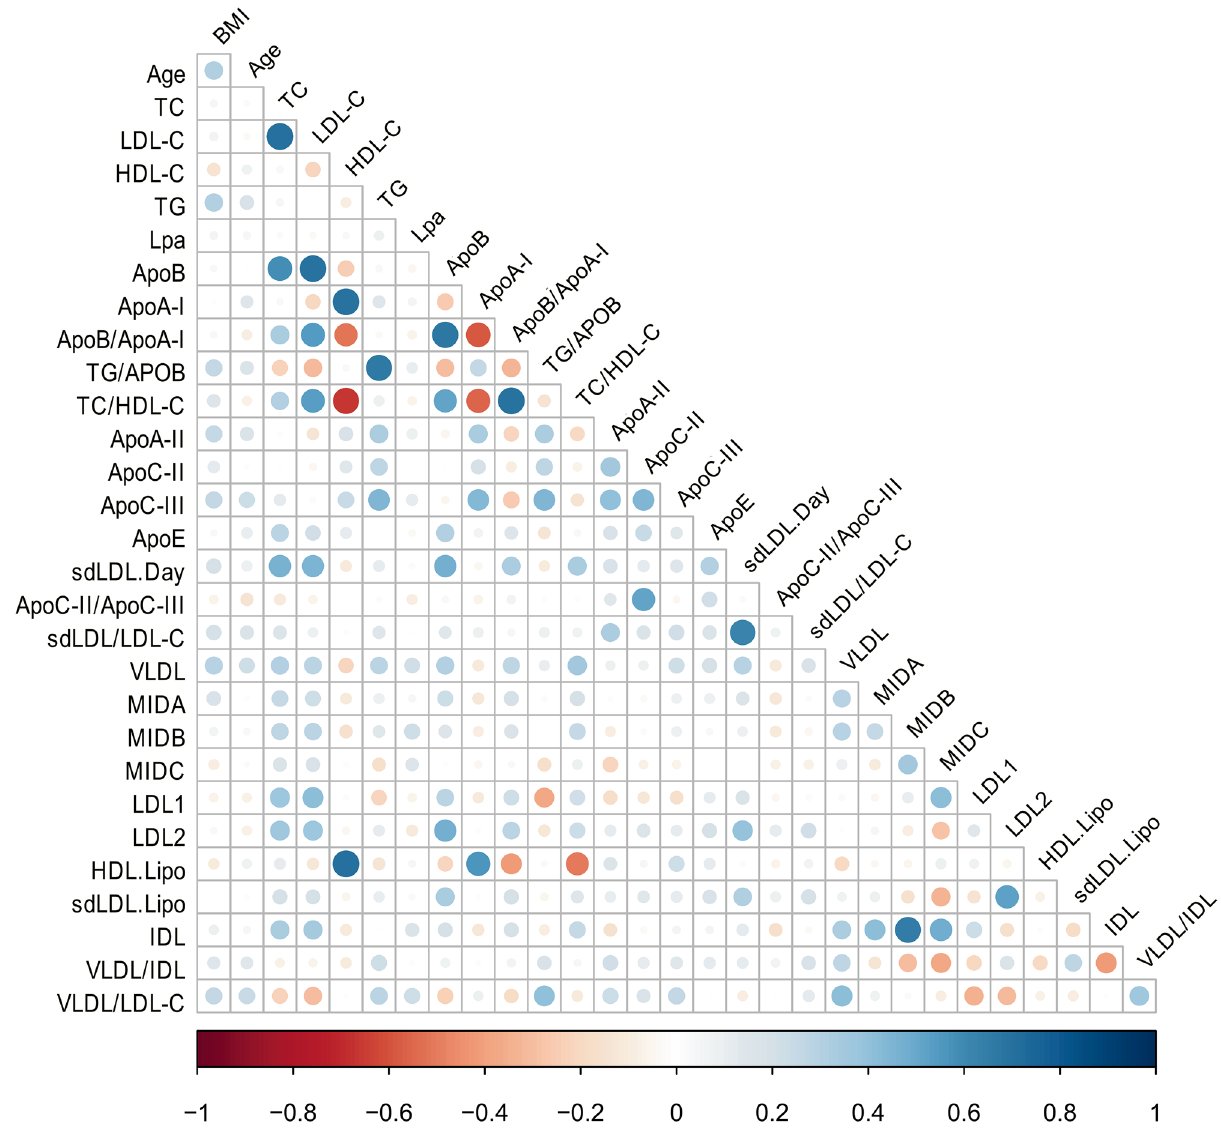
Figure 2. Correlation plot for the dataset parameters. Negative and positive correlations are presented in red and blue, with darker colours corresponding to higher absolute values, according to the scale.